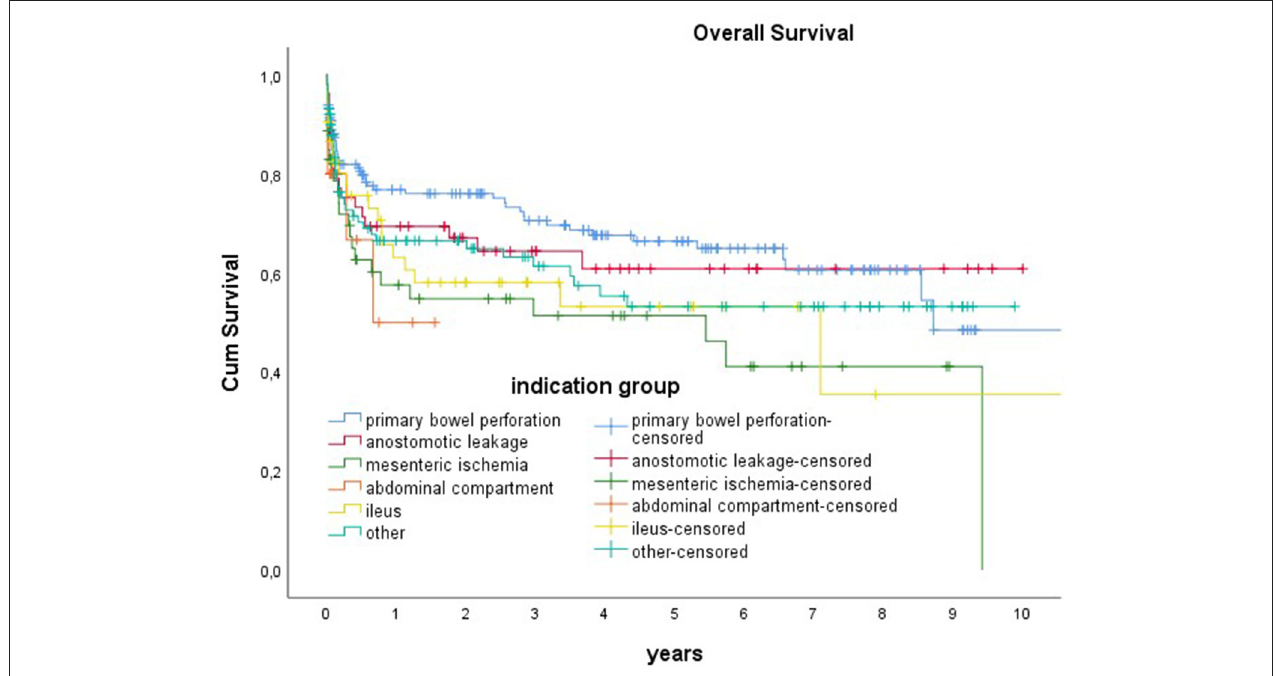
FIGURE 3 | Overall survival for different